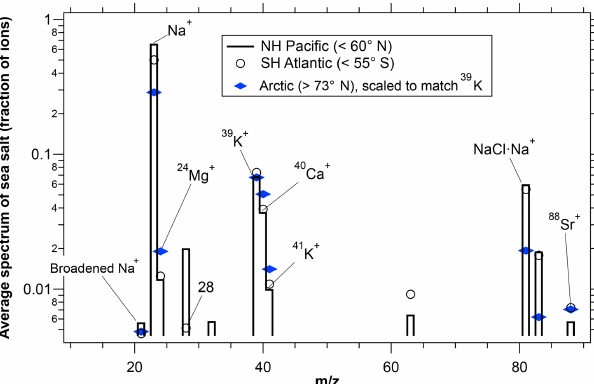
Figure 5. Average spectra of sea-salt particles larger than 1µm di- ameter for the Arctic and lower latitude regions during ATom2. Na peaks were smaller over the Arctic Ocean than over the Pacific Ocean in the Northern Hemisphere . The South Atlantic is included to provide an estimate of consistency between regions that should be similar. Spectra were selected that have ion intensities large enough to measure minor peaks but that will not significantly saturate the Na peak. n ≈ 5500 for the NH Pacific, 700 for the SH Atlantic, and 300 for the